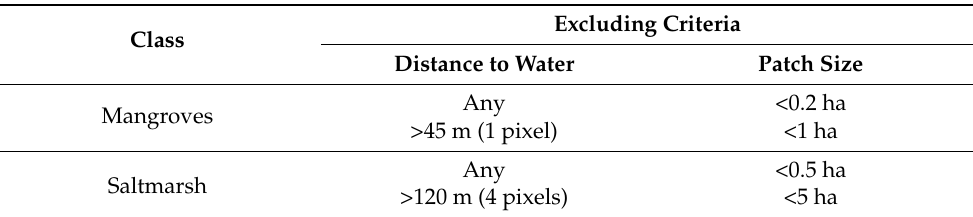
Table 2. Post-classification spatial filter applied to our land-use maps. It searches for uncommon (less than 5% of all pixels in the ground-truthed training datasets met these criteria) mangrove and saltmarsh patches and removes them according to the following excluding criteria. Class